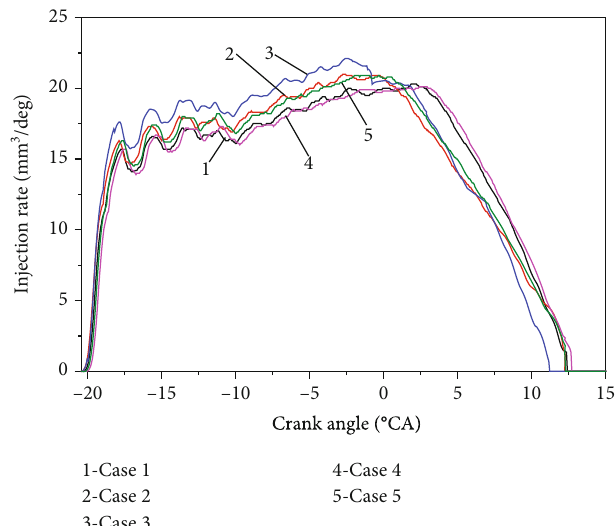
Figure 9: Fuel injection rate with constant fuel injection